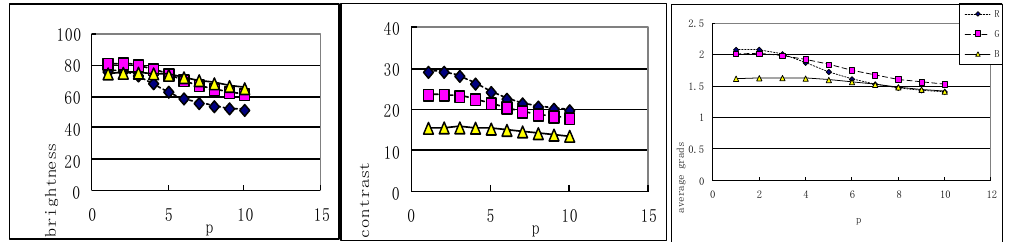
Figure 3 . Change trends of brightness, contrast and average gradients when p value from 1~10 in true color aerial image shadow removal